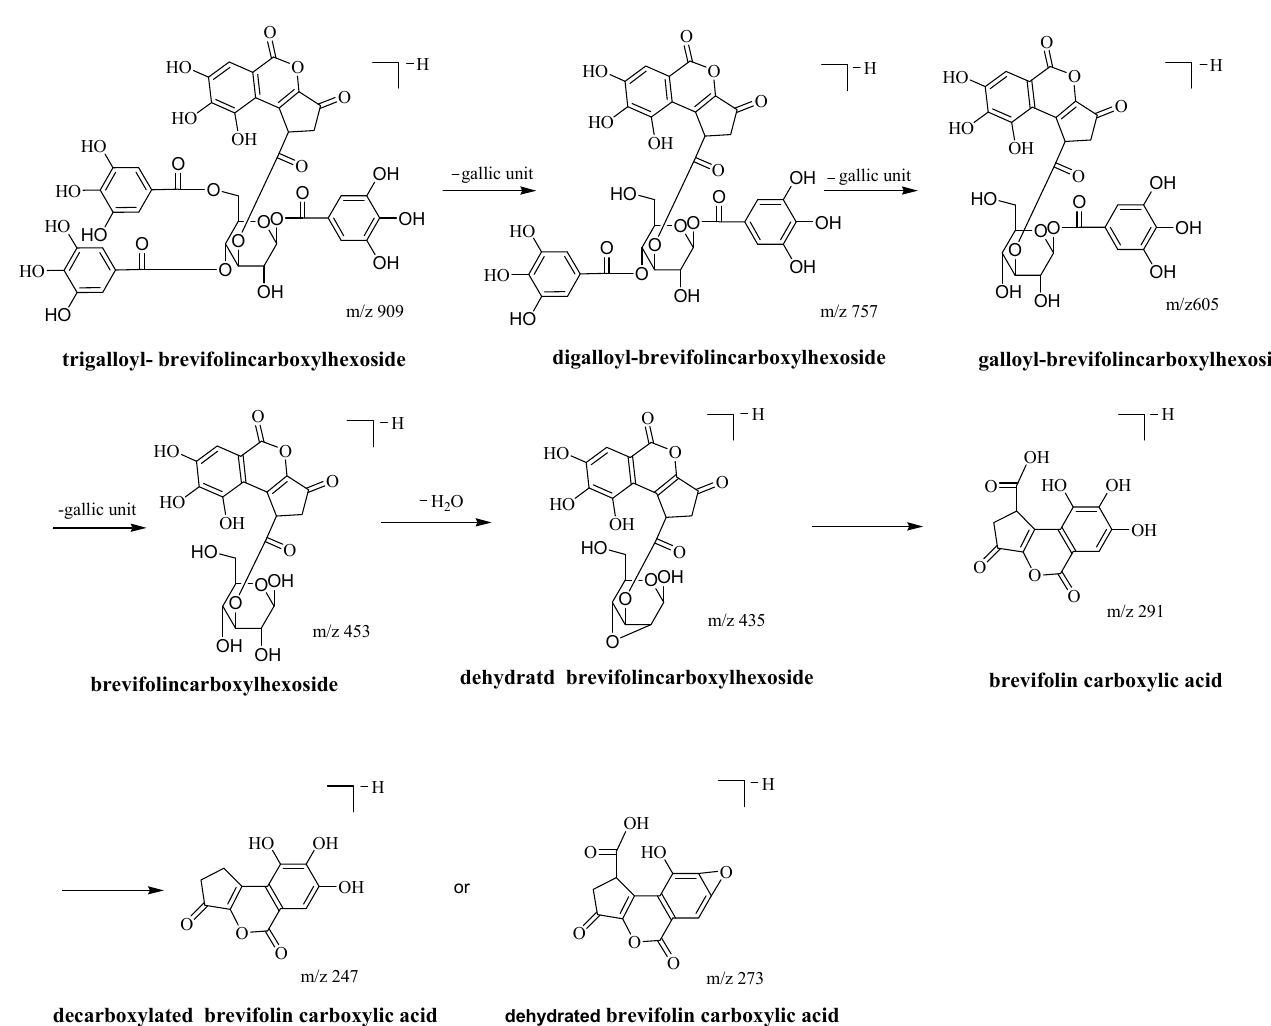
Figure 2. Postulated fragmentation pathways of brevifolincarboxyl-trigalloyl-hexoside (illustrated by 1,4,6- O -trigalloyl- 3- O -brevifolincarboxyl- β - D -glucose). A2 exhibited an [M-H] − ion at m / z 605.0013, with a retention time of 18.36 min, that released a fragment ion at m / z 331.0200, corresponding to a monogalloyl-hexoside moiety ( C1-1 ). This resulted from the loss of a brevifolincarboxyl moiety (274 Da) from the [M-H] − ion. Monogalloyl-brevifolincarboxyl-hexoside was tentatively assigned to A2 . Moreover, a fragment ion at m / z 453.0401 attributed to the brevifolincarboxyl-hexoside moiety, resulting from the loss of a galloyl unit from its pseudo-molecular ion. This supported the identification of A2 . Typical fragment ions for galloyl moiety were found at m / z 169.0128 and 125.0230. Those for the brevifolincarboxyl moiety were observed at m / z 247.0255, 273.0026, and 291.0116 and supported the identification of A2 . The frag- ment ions at m / z 587.0662 and 435.0555 were obtained from the consecutive loss of H 2 O (18 Da) and galloyl (152 Da) moieties, respectively, from the pseudomolecular ion. Mo-